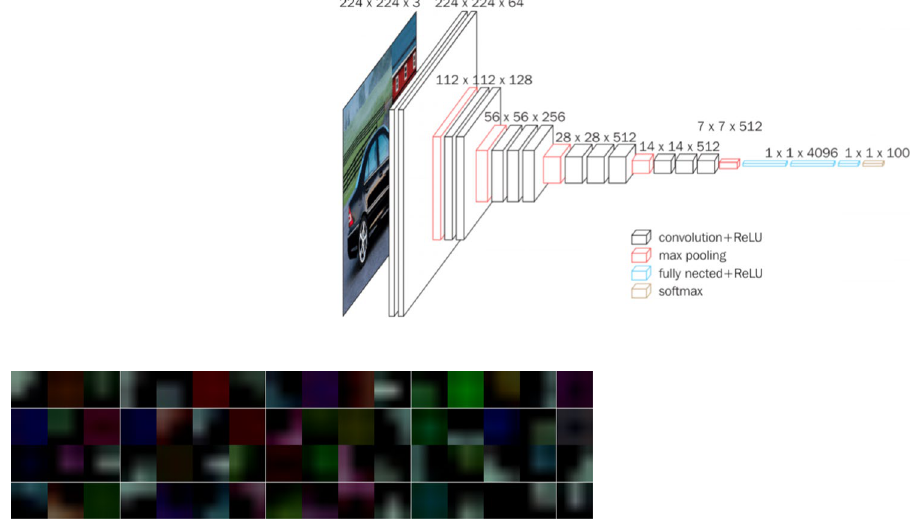
Fig. 9 The resulting images from each layer of the VGG16 architecture Simonyan and Zisserman [28]. Given a new data set (i.e. the Pneumonia Chest X-ray dataset), we can feed each image into the VGG16 architecture to create feature maps from using the parameters and filter kernels in the original VGG16